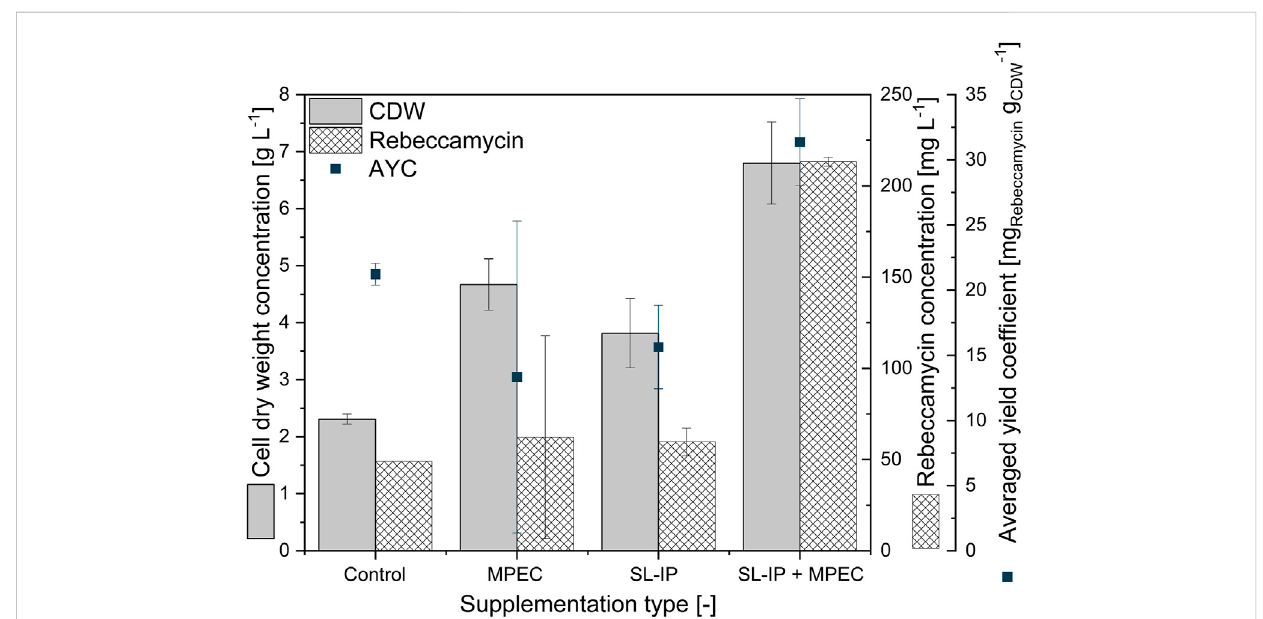
FIGURE 9 Cell dry weight concentration, rebeccamycin concentration, and averaged biomass-related product yield coef fi cient (AYC) of 10-day L. aerocolonigenes cultivation of an unsupplemented control culture, MPEC supplemented with glass microparticles (10 g · L − 1 , x 50 = 7.9 µm), soy lecithin-